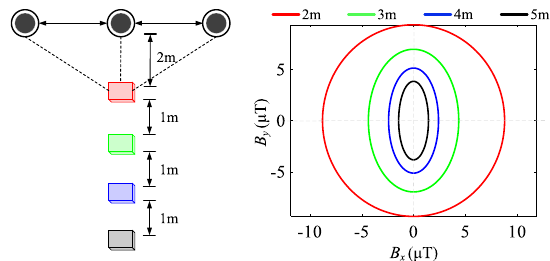
Fig. 8 Magnetic field trajectory at different distances between sensor and lines